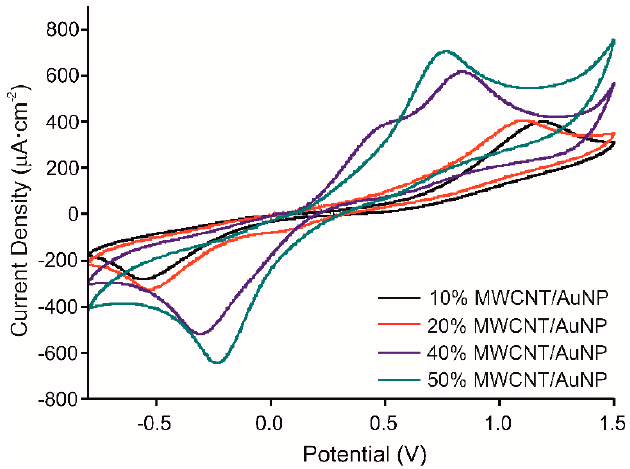
Figure 3. Voltammetric responses of the MIP CS-MWCNT / AuNP nanocomposite modified BDD electrode in 10 − 3 M catechol in 0.1 M, pH 7.4 PBS solution with increased concentrations of MWCNT / AuNP composite, 10% in black, 20% in red, 40% in blue and 50% in green.